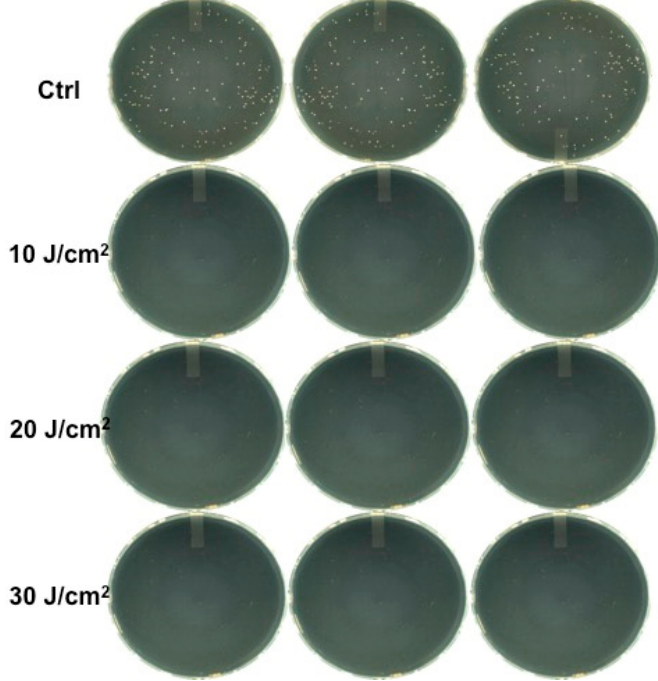
Figure 3. Colonies observed in agar plates after 20 μ L from every Eppendorf tube with erythrosine irradiated with the 532 nm green diode laser was taken, streaked on a plate, and incubated for one day.